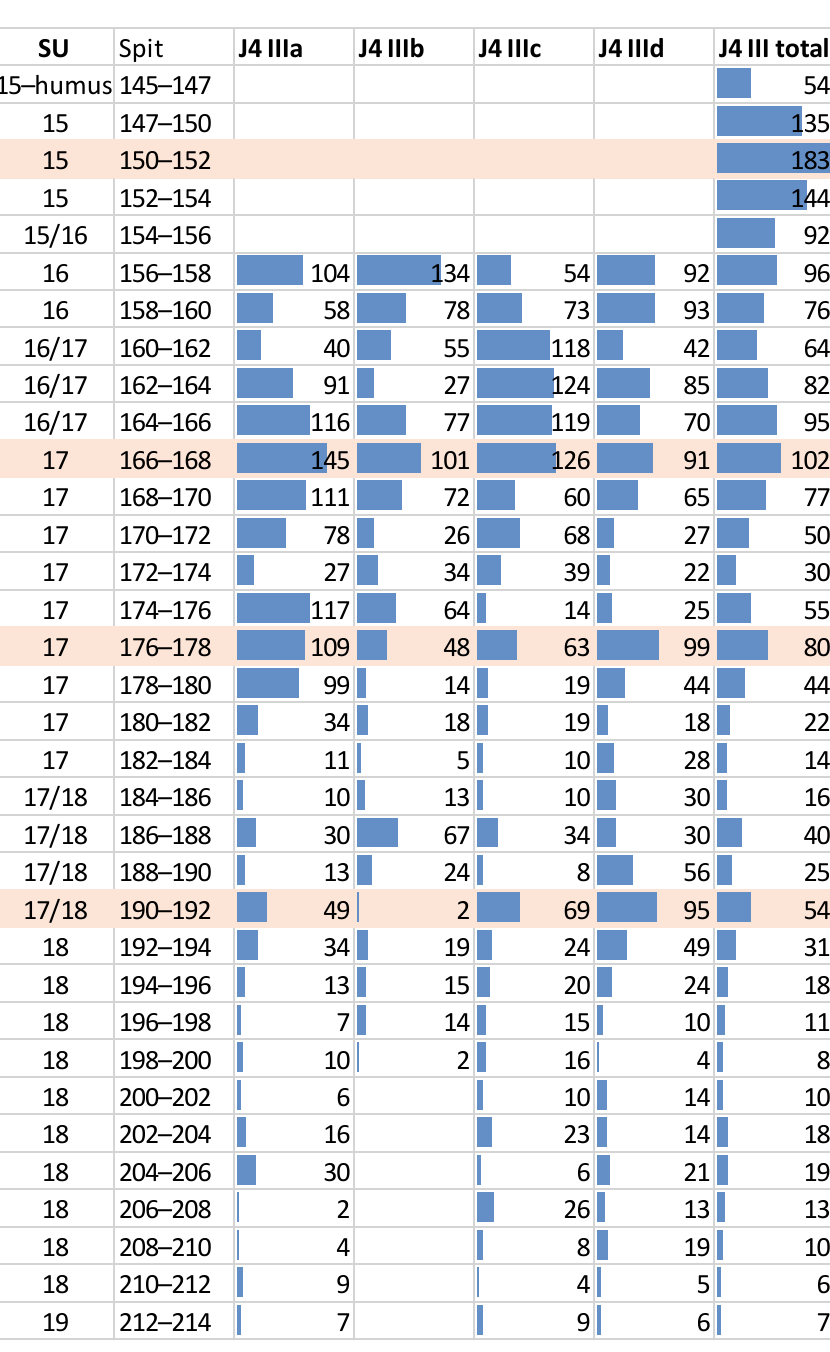
Figure 4. Density of micromammal remains (MNE/L) along the stratigraphic sequence of the quarter of a square metre J4 III and its smaller subdivisions (a, b, c, and d). Spits highlighted in orange correspond to maximum density peaks. SU: Stratigraphic Unit.